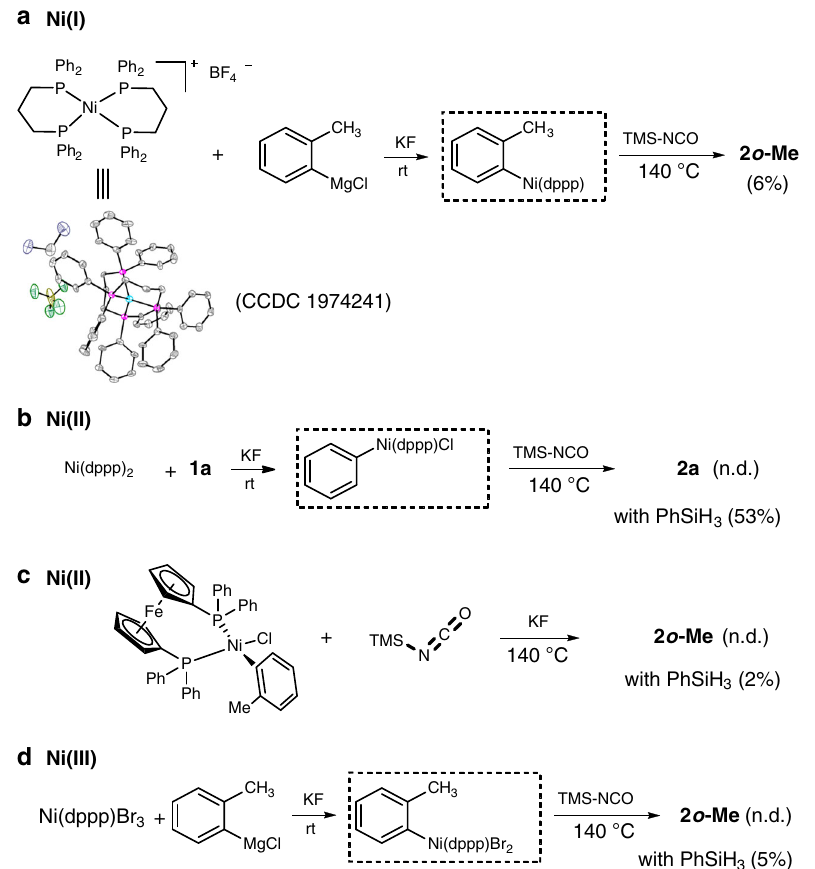
Fig. 7 Stoichiometric reactions relevant to mechanism. a Reactivity of Ar – Ni(I) generated in situ. b Reactivity of Ar – Ni(II) generated in situ. c Reactivity of Ar – Ni(II). d Reactivity of Ar – Ni(III) generated in